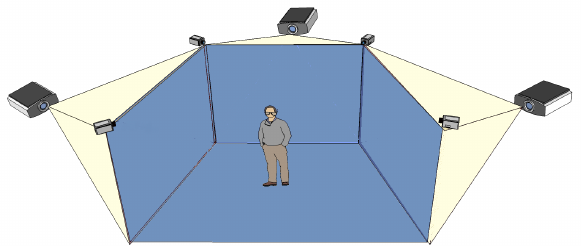
Figure 1: Schematic of CAVE. Four walls play the role of dis- play while projectors are installed behind them. Infra-red track- ing cameras mounted on top of walls capture the motion of